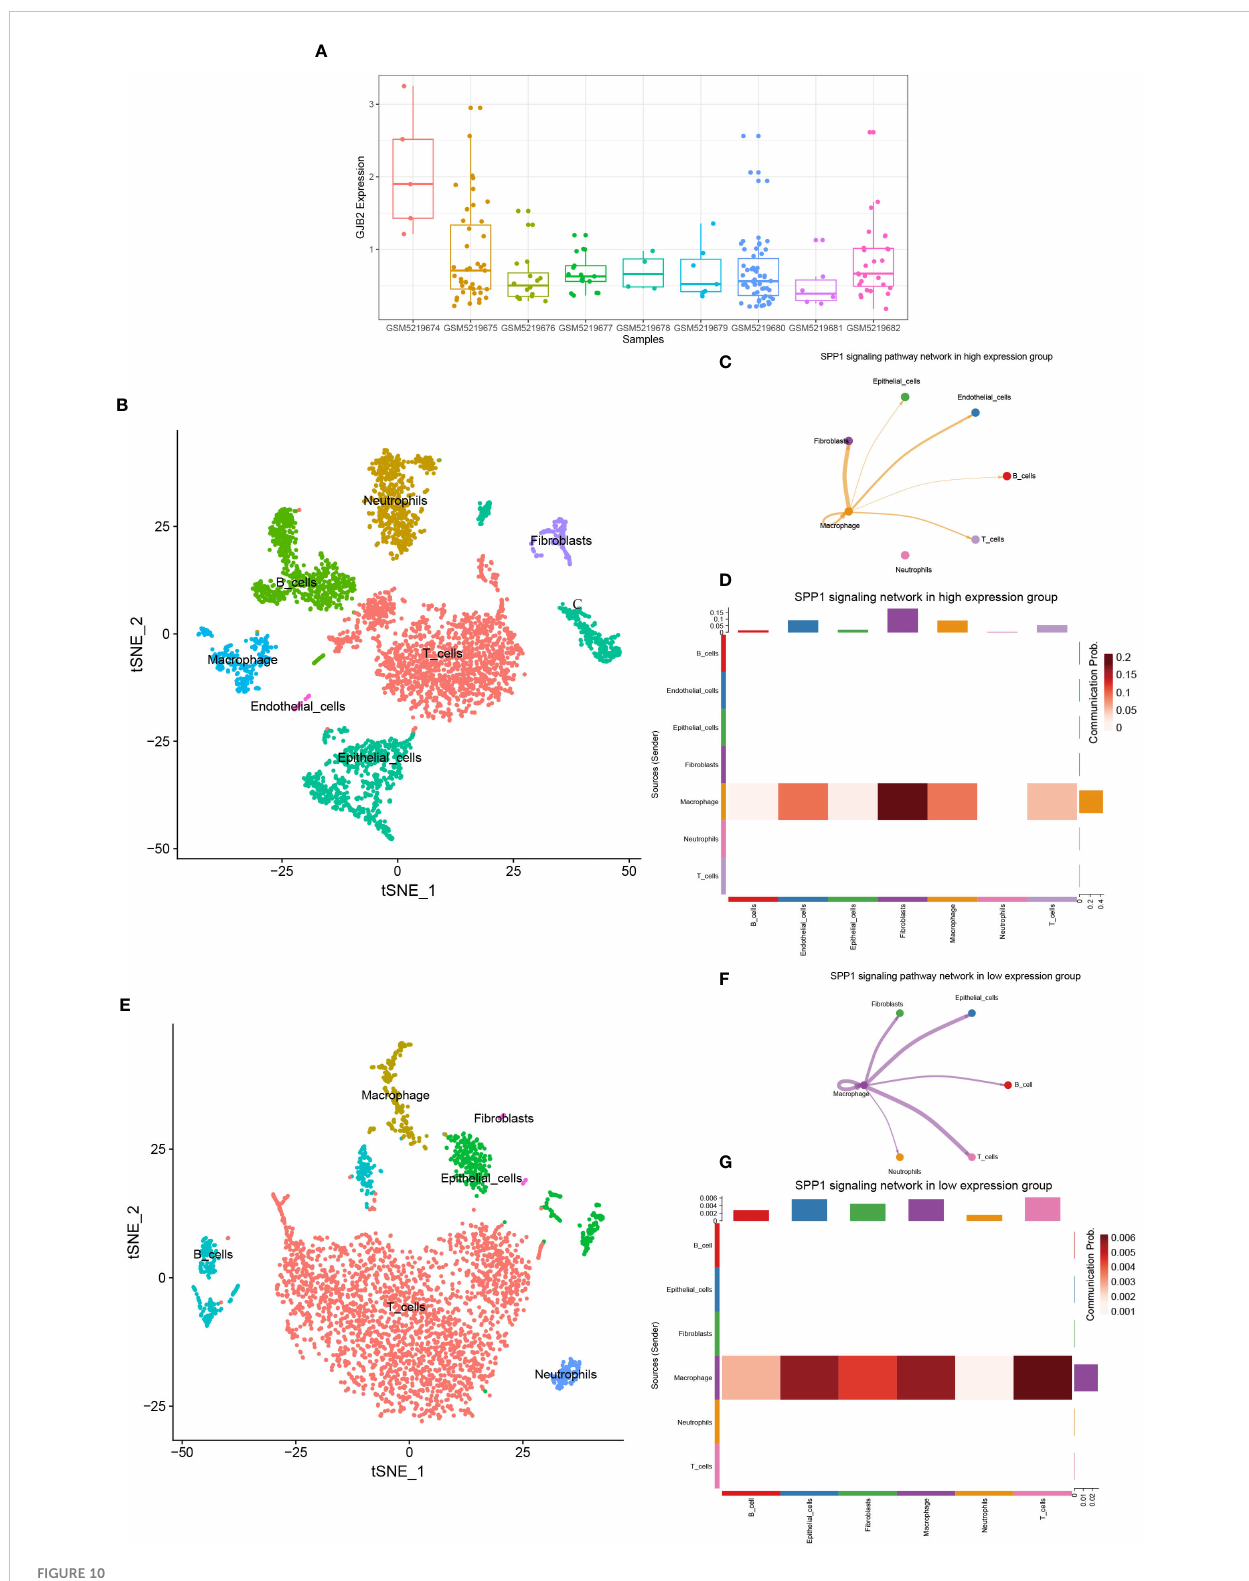
FIGURE 10 (A) GJB2 expression in each sample in the single-cell dataset. (B) TSNE plots of GJB2-high expression scRNA-seq data. (C) SPP1 signaling pathway network in high expression group. (D) The intercellular communication probability between different cell types in the SPP1 signaling network in high expression group. (E) TSNE plots of GJB2-low expression scRNA-seq data. (F) SPP1 signaling pathway network in low expression group. (G) The intercellular communication probability between different cell types in the SPP1 signaling network in low expression